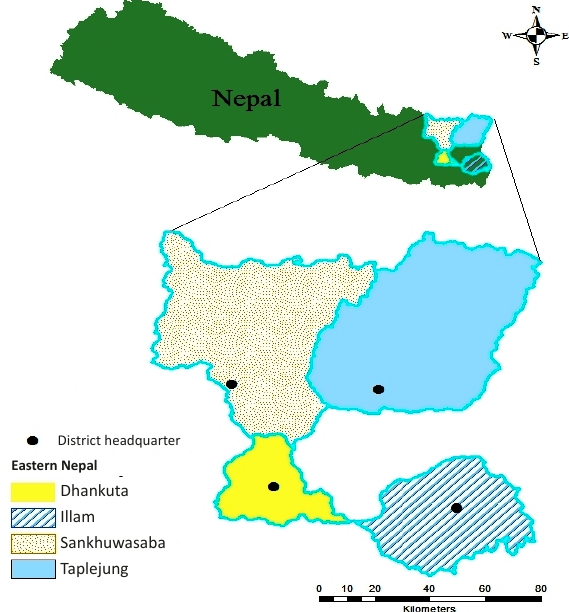
Figure 1. Sudy area in eastern Nepal